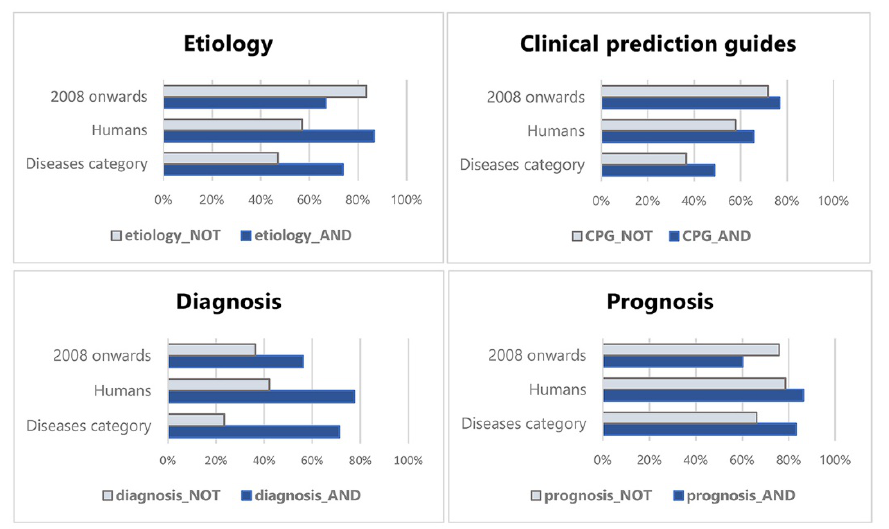
Figure 3 Proportion of citations matching selected criteria for each part of Filter